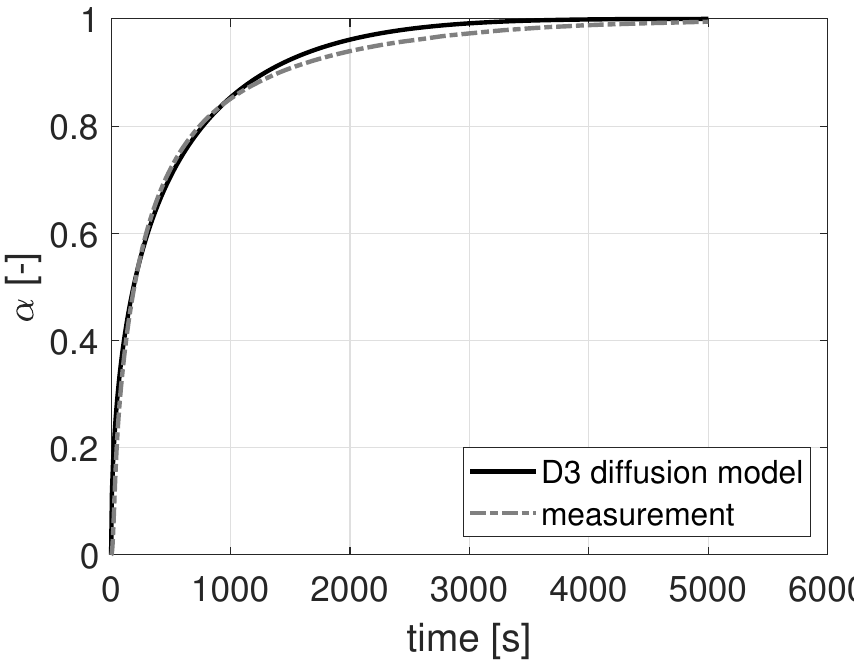
Figure 11. The hydration conversion versus time for the one-process diffusion-limited model (D3). Fitting results: φ = 6.9975 × 10 − 5 [mol m − 2 s − 1 ], R 2 =